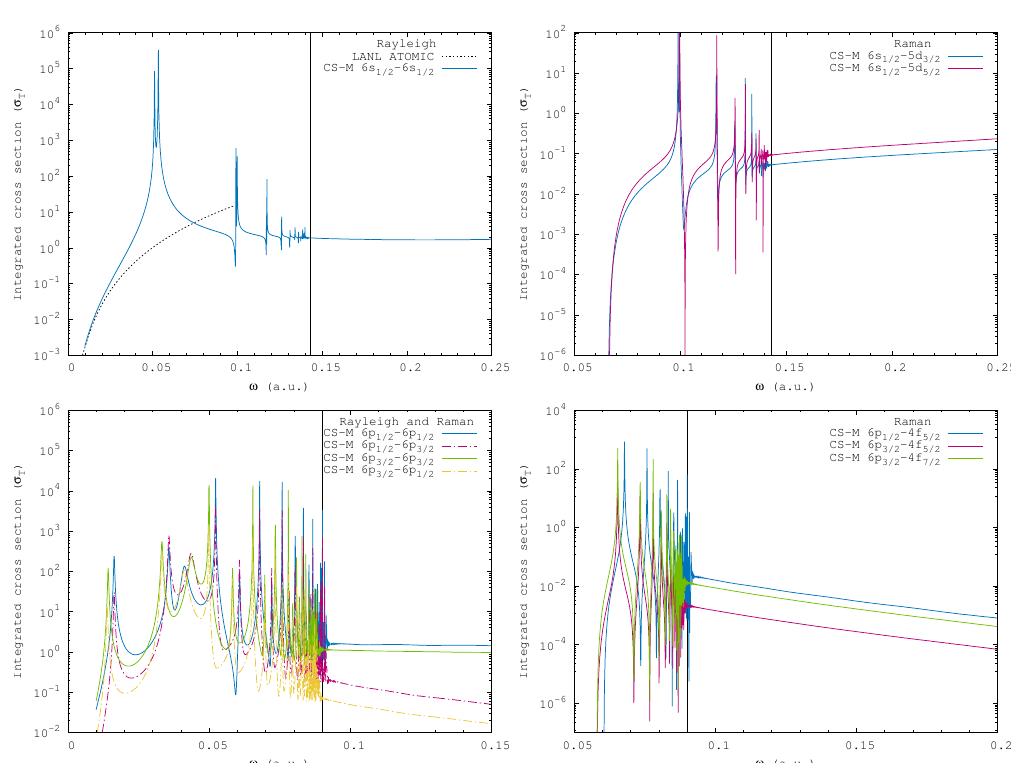
Figure 9. Same as Figure 5 but for cesium with resolved fine structure